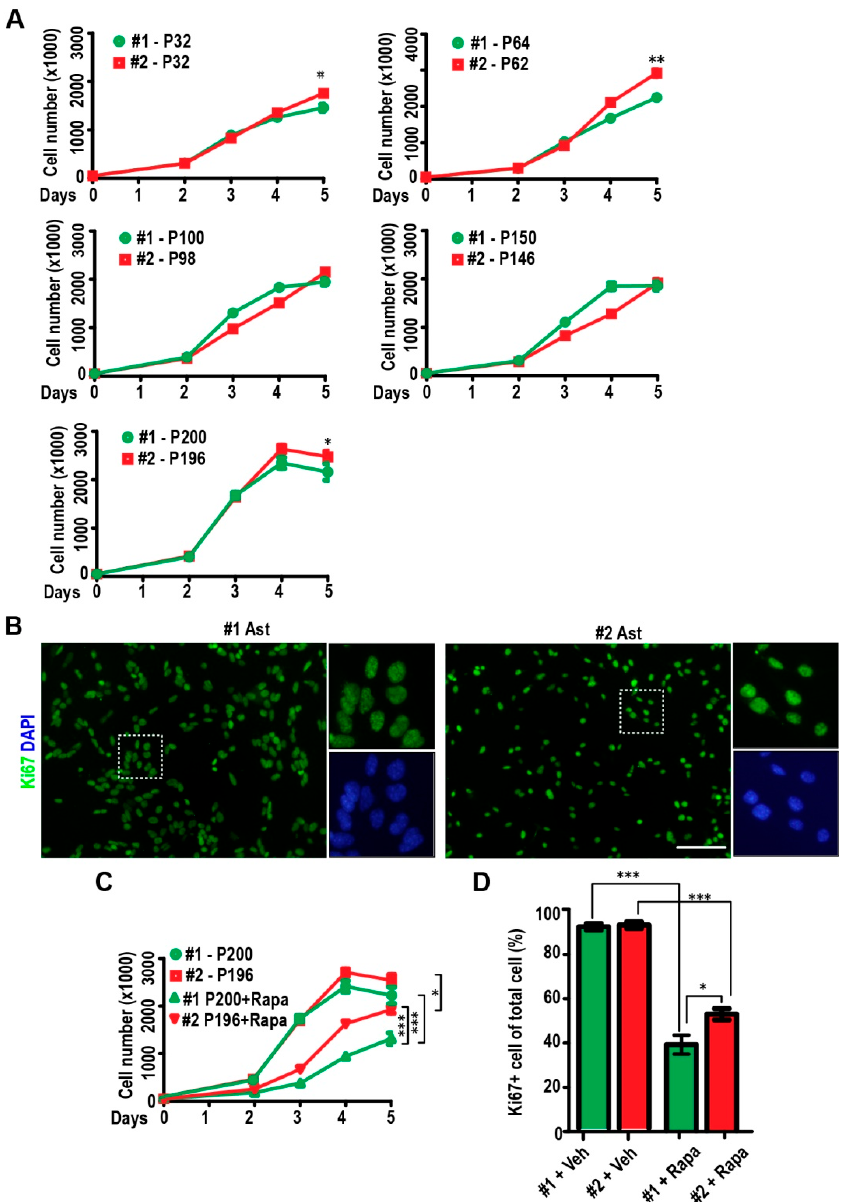
Figure 2. Growth of immortalized Ast #1 and Ast #2 cells in vitro. ( A ) Mean ± S.E. of cell number from Ast #1 and Ast #2 for 0, 2, 3, 4, and 5 days in culture at different passages were shown. Experiments were repeated 5–6 times for each time point. ( B ) Immunofluorescent staining of Ki67 and DAPI in immortalized astrocytic cell lines. Boxed areas are shown in detail on the right. Images are representative for 5 independent experiments. ( C ) Mean ± S.E. of cell number from Ast #1 and Ast #2 treated with vehicle or Rapamycin for 0, 2, 3, 4, and 5 days in culture at passages of 200 (Ast #1) and 196 (Ast #2) are shown. Experiments were repeated 5–6 times for each time point. ( D ) Mean ± S.E. of the percentage of Ki67 positive cells in Ast #1 and Ast #2 treated with vehicle or Rapamycin for 1 day in culture are shown. Experiments were repeated 5 times. More than 1000 cells were